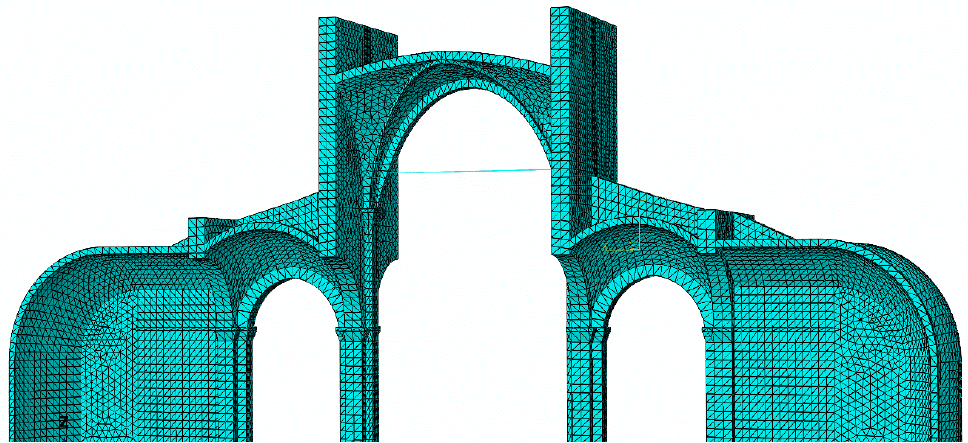
Figure 7. St. Bassiano church: numerical model for structural analysis, representing a transversal slice of one bay with the nave, two aisles and two external chapels.